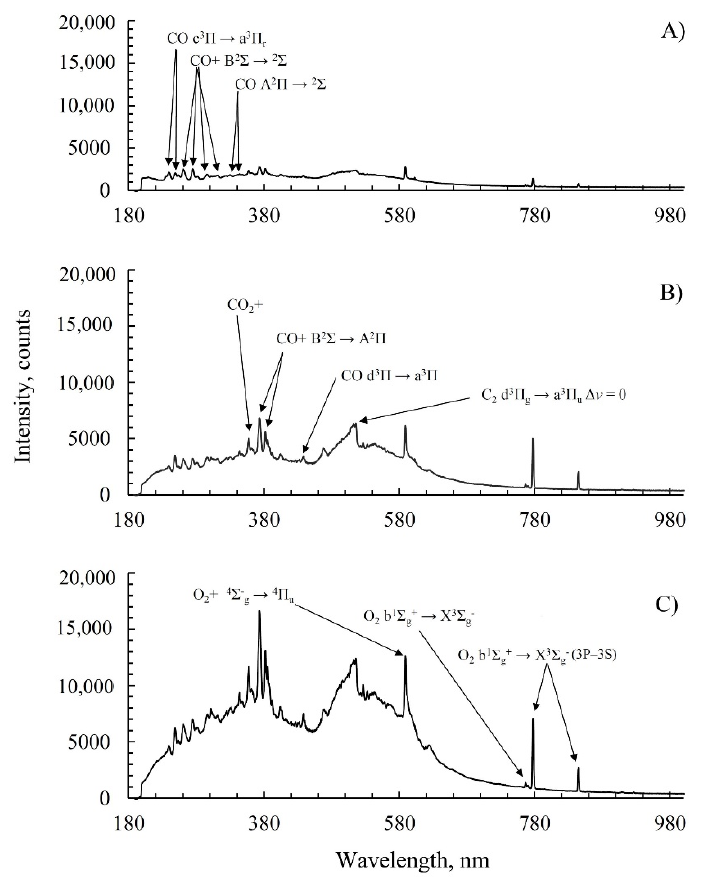
Figure 3. Emission spectrometry of carbon dioxide under different frequencies with the stable voltage U = 8300 V: ( A ) F = 60 kHz; ( B ) F = 180 kHz; ( C ) F = 220 kHz.